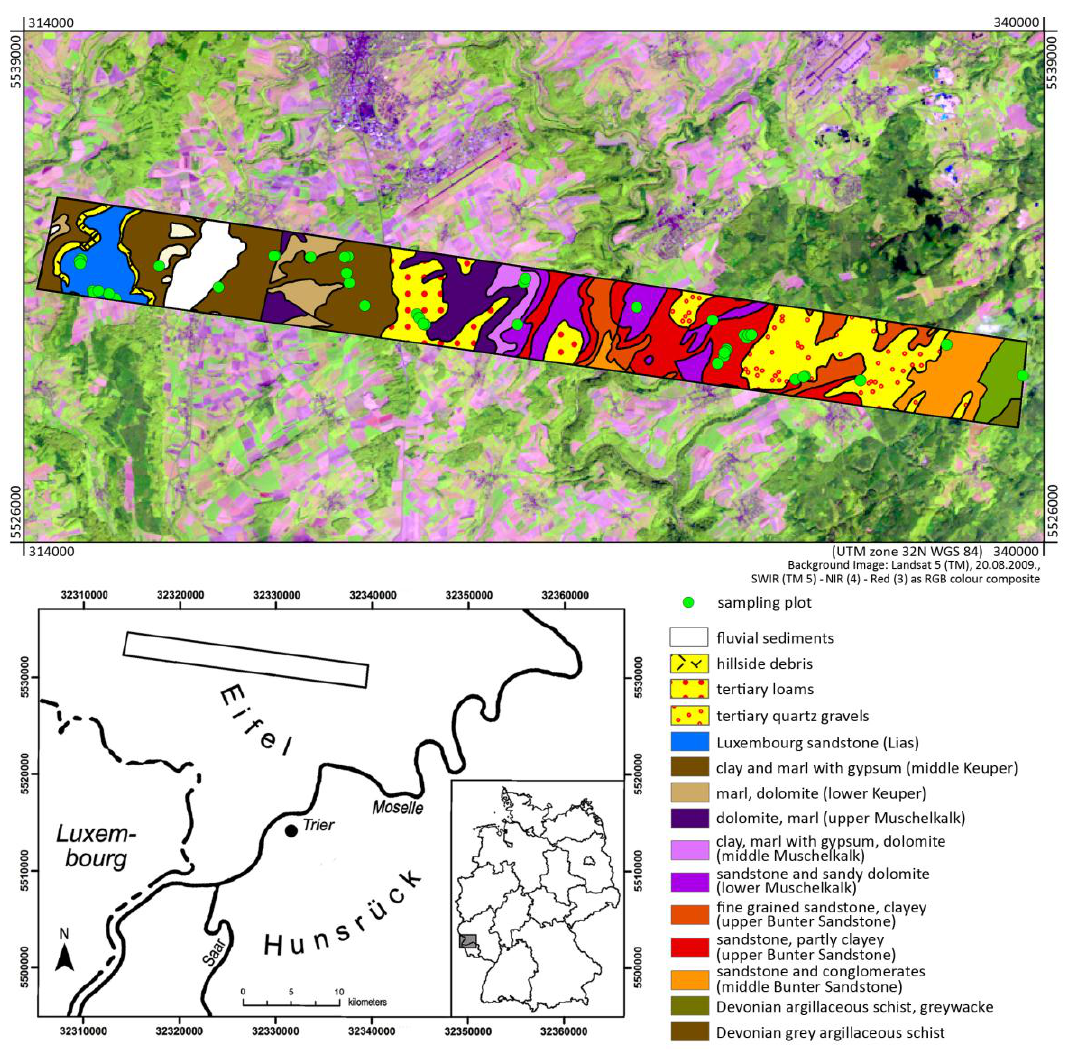
Figure 1. Location of the study region with HyMap flight stripe, geological situation and sampling positions (geological data modified after Wagner [46]).